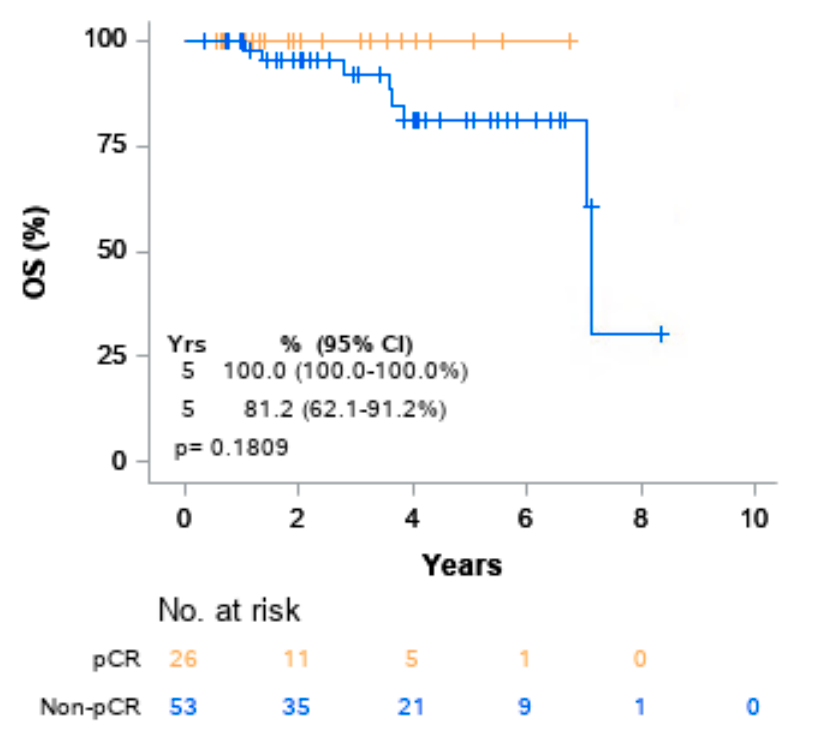
Figure 2. Kaplan–Meier curves of overall survival (OS) by pCR.